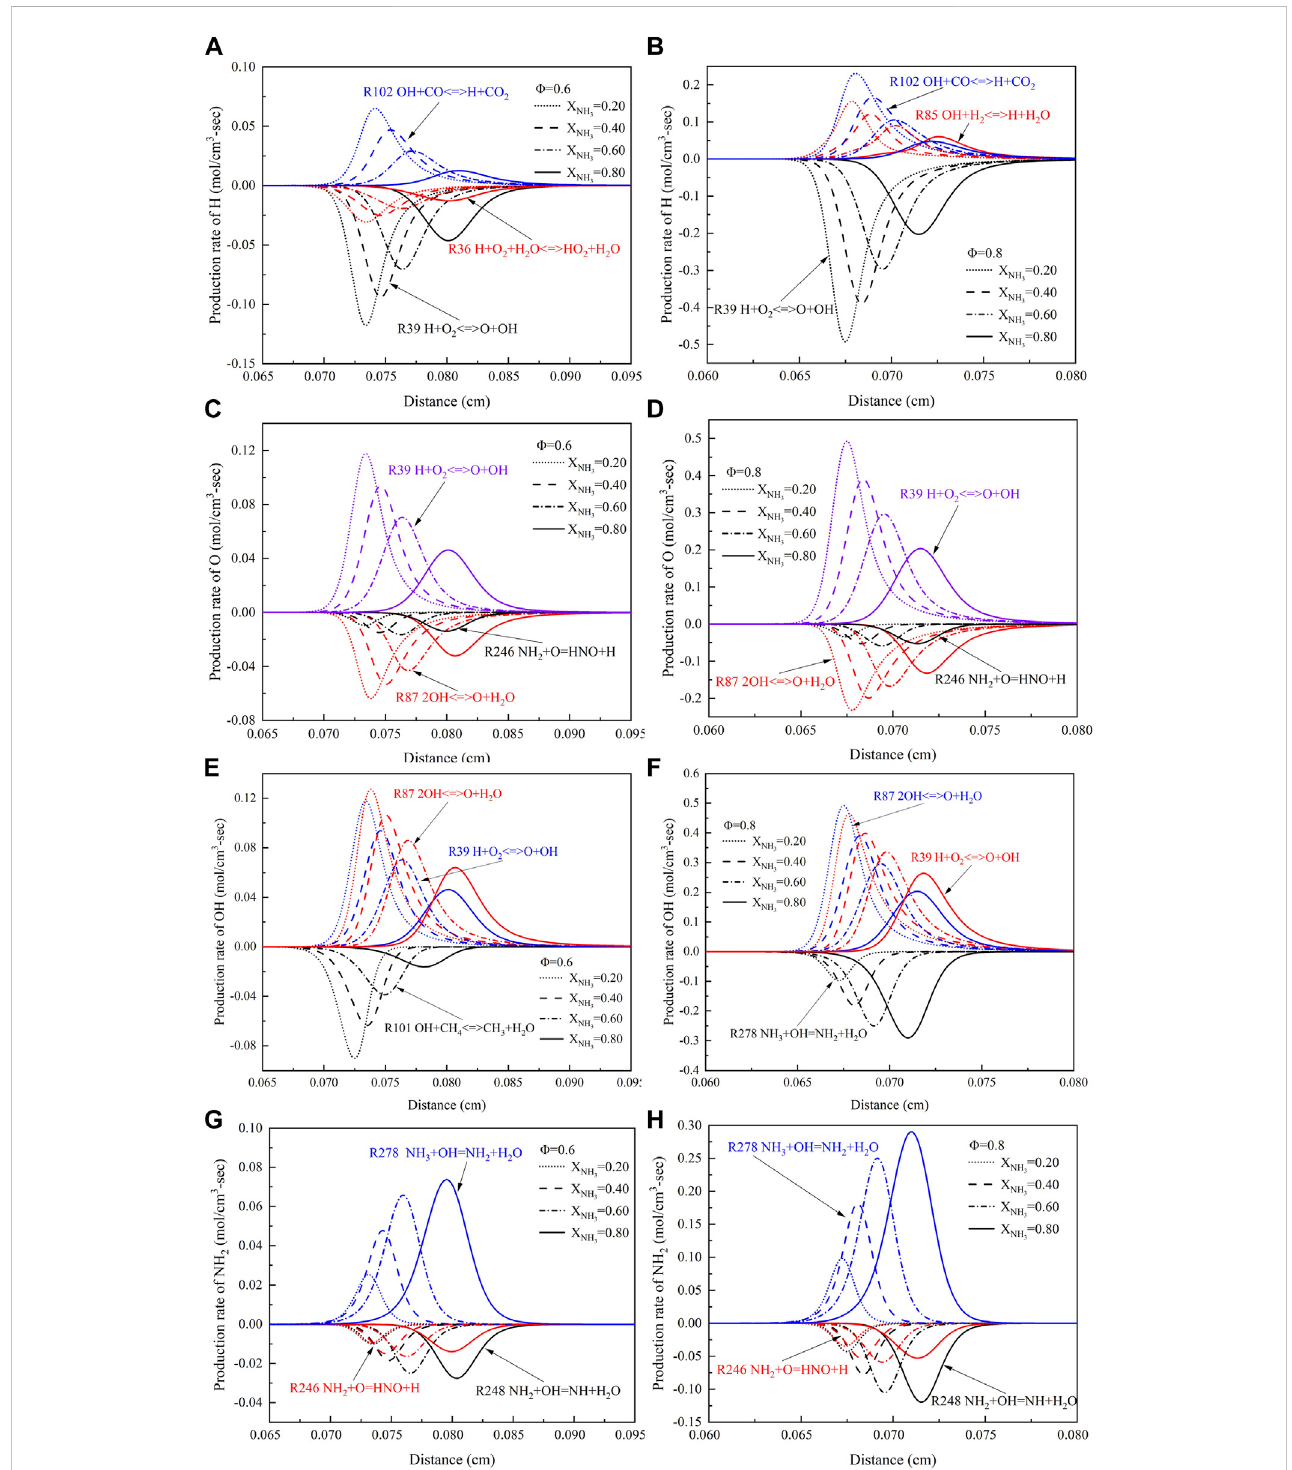
FIGURE 7 ThegenerationrateofH,O,OH,andNH 2 withdifferentammoniacontent: (A) When Φ =.6,thegenerationrateofH; (B) When Φ =.8,thegenerationrate of H; (C) When Φ = .6, the generation rate of O; (D) When Φ = .8, the generation rate of O; (E) When Φ = .6, the generation rate of OH; (F) When Φ = .8, the generation rate of OH; (G) When Φ = .6, the generation rate of NH 2 ; (H) When Φ = .8, the generation rate of NH 2 . (T = 723 K, p = 16.5